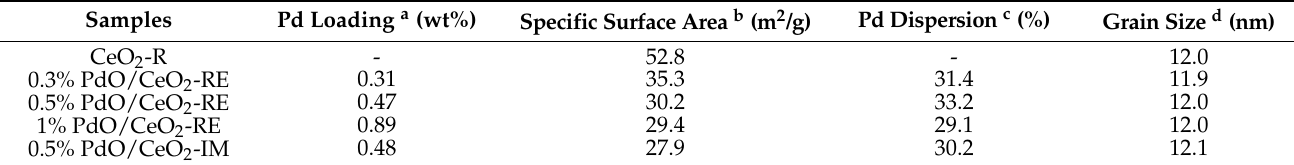
Table 1. Pd content, dispersion and texture parameters of CeO 2 -R and Pd/CeO 2 catalysts.